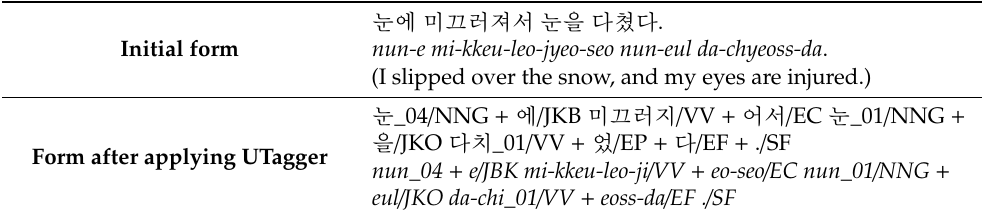
Table 8. A morphological analysis and word-sense annotated